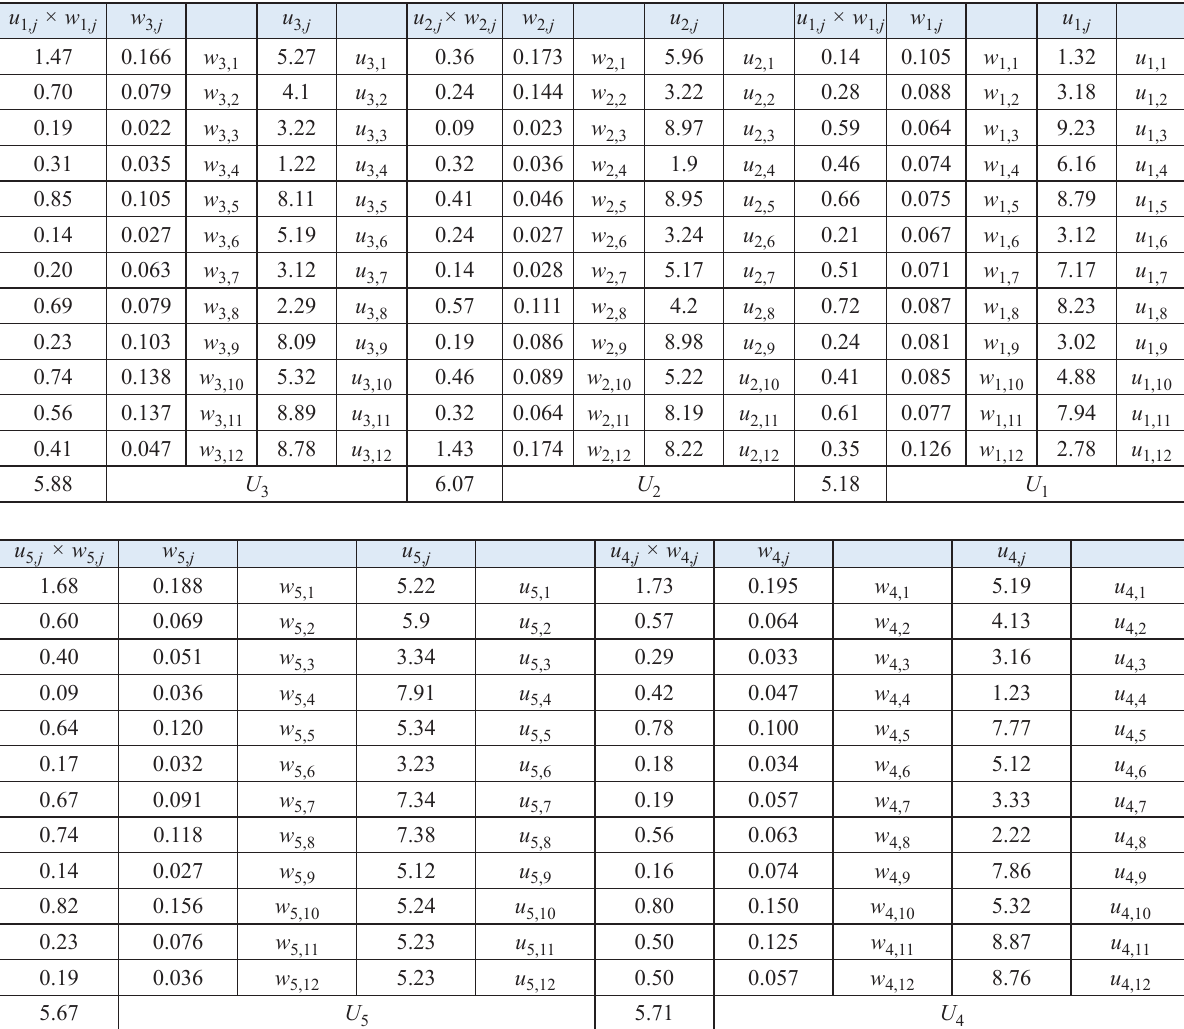
Table 22. Calculation table of scores of indexes ( U i ) u 1 ,j × w 1